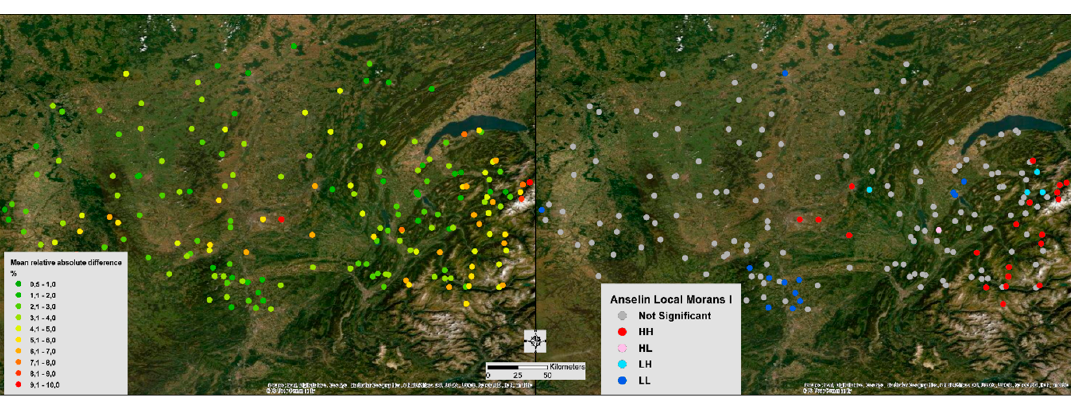
Figure 3. Averages of the absolute relative differences for the six days ( left ) and spatial clustering of the statistically close relative differences values (LISA— right ).